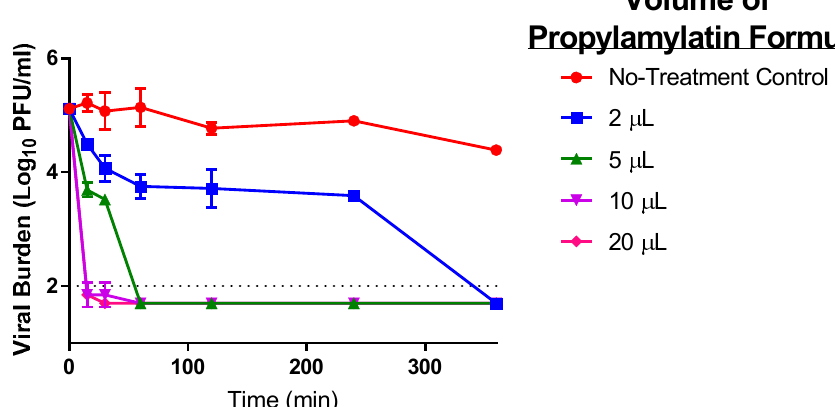
Figure 4. The antiviral effect of various volumes of the Propylamylatin formula to inactivate infectious SARS-CoV-2. A 1 mL suspension of 10 5 PFU of SARS-CoV-2 was directly exposed to various volumes of liquid Propylamylatin formula and incubated at 37 ◦ C. At various times post-Propylamylatin-formula exposure, viral suspensions were harvested, and the viral burden was quantified by plaque assay in Vero E6 cells. Viral burden is reported as log 10 PFU/mL. Data points correspond to the geometric mean of two independent samples and error bars represent one standard deviation. The horizontal dashed line signifies the plaque assay limit of detection.